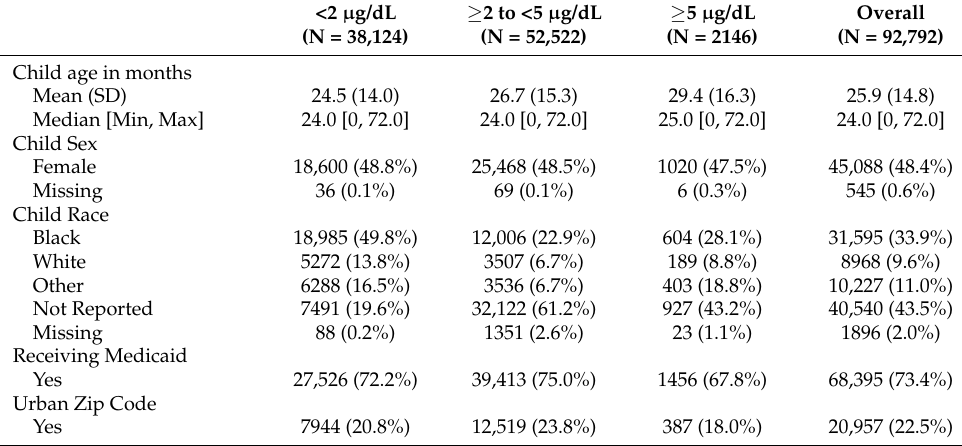
Table 1. Sample demographic characteristics of the 92,792 urban and suburban children 0–72 months of age with a valid venous blood lead test (2010–2018) in the Atlanta metro area.